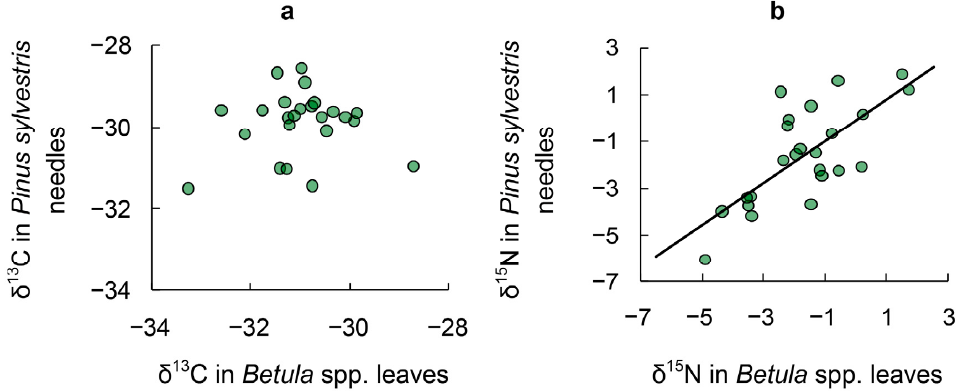
Figure 4. The scatter plots of δ 13 C ( a ) and δ 15 N ( b ) in the Pinus sylvestris needles on the δ 13 C and δ 15 N in the Betula spp. leaves. Solid line in ( b ) is the empirical regression line.